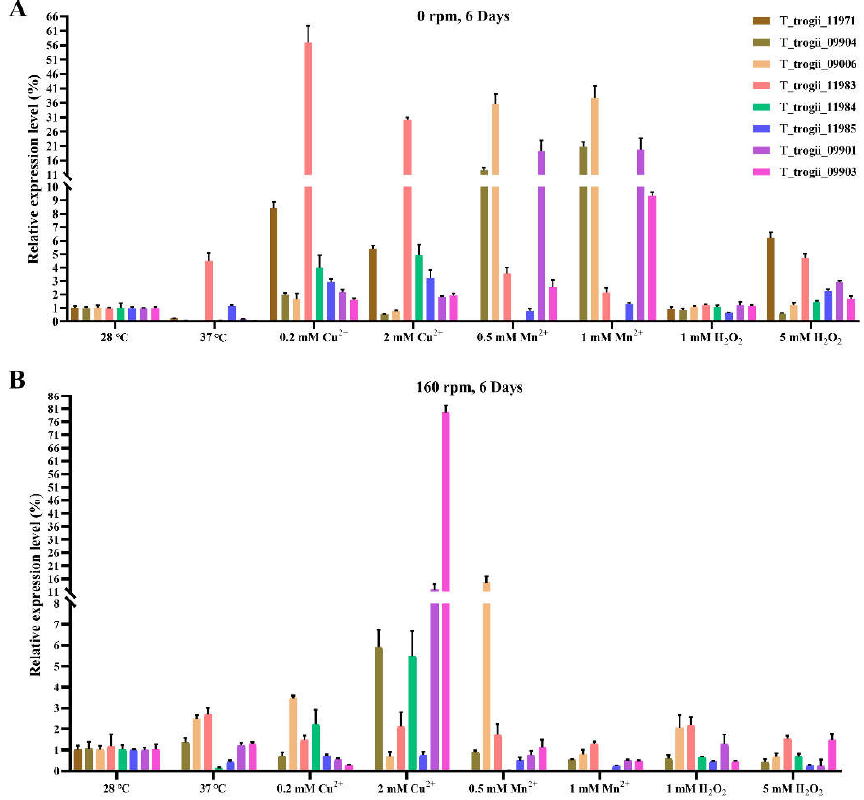
Figure 6. Gene expression patterns of MnPs in T. trogii S0301 treated with Cu 2+ , Mn 2+ , and H 2 O 2 and temperatures under static ( A ) and shake ( B ) liquid culture by q-PCR.